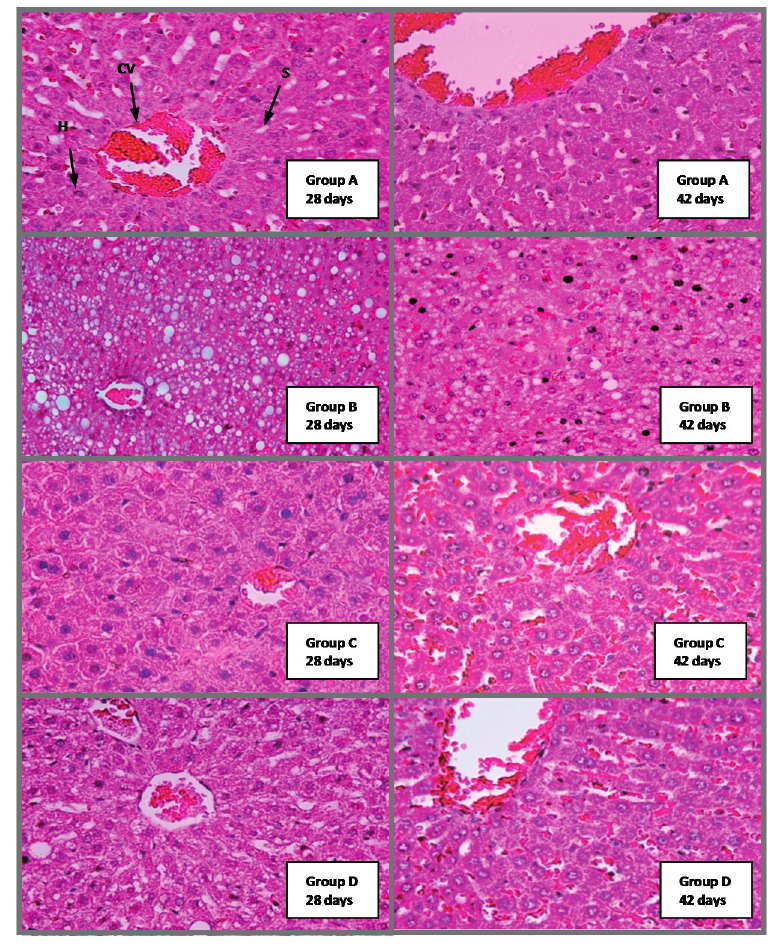
Figure 5. The Effect of P. macrocarpa leaves on liver of hypercholesterolemia induced rat of group A, B, C and D at 28 and 42 days. A: control non cholesterol group; B: control cholesterol group; C: 0.5 g/kgbw of EMD treated rats; D: 0.25 g/kgbw of EMD treated rats. CV = Central Vein; H = Hepatocytes; S = Sinusoids. H&E staining, magnification =